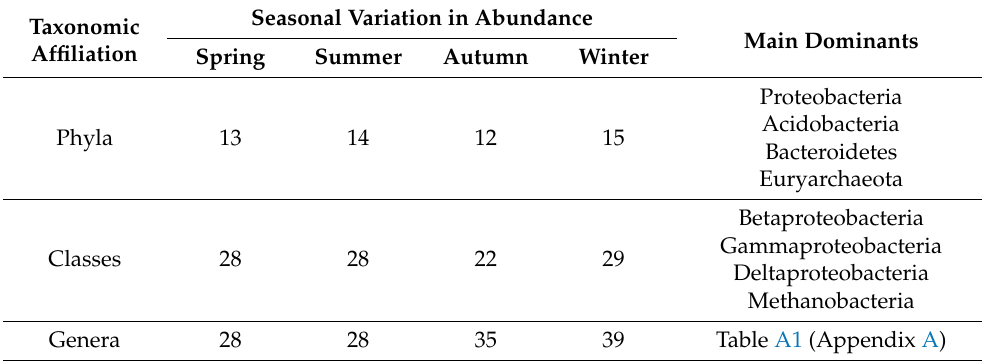
Table 1. Seasonal changes in the number of dominant bacteria in the bottom sediments based on taxonomic affiliation: